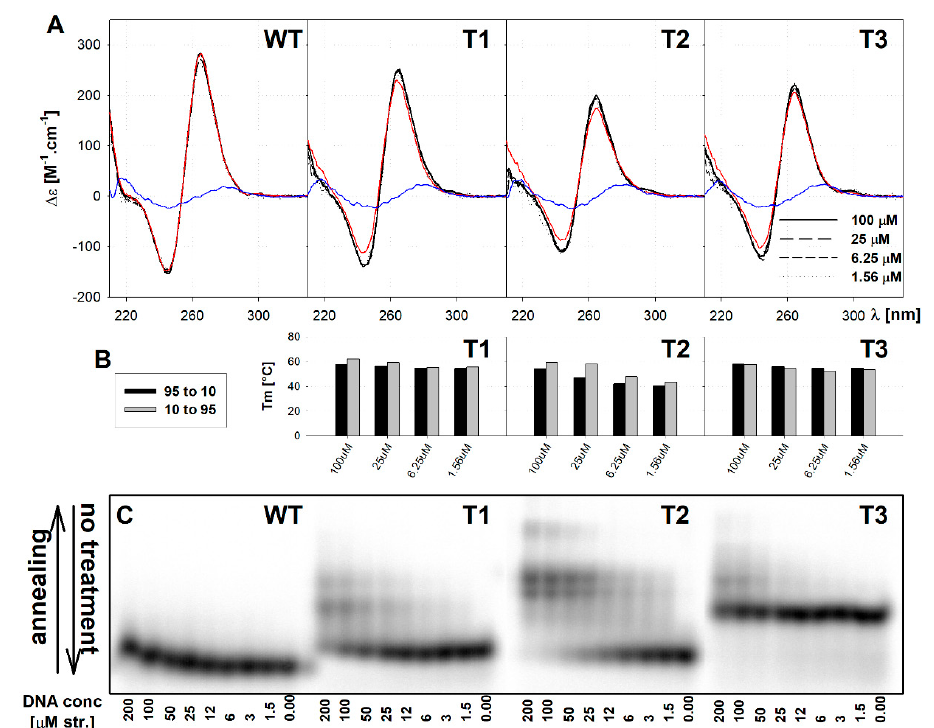
Figure 4. Dependence of the G4 properties of WT and selected mutated sequences on DNA Figure4. DependenceoftheG4propertiesofWTandselectedmutatedsequencesonDNAconcentration concentration in 100K buffer . ( A ) The CD spectra ( B ) T m values from renaturation (black) and in 100K bu ff er. ( A ) The CD spectra ( B ) T m values from renaturation (black) and denaturation (gray) profile and ( C ) native PAGE o. Red CD spectra correspond to samples slowly annealed in 100K bu ff er at 100 µ M DNA strand concentration. Blue CD spectra correspond to denatured samples measured at 98 ◦ C in 1Nf bu ff er at 3 µ M strand